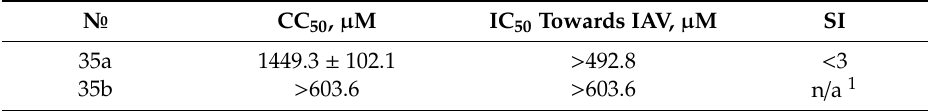
Table 2. Antiviral activity of compounds 35a,b towards influenza virus A / Puerto Rico / 8 / 34